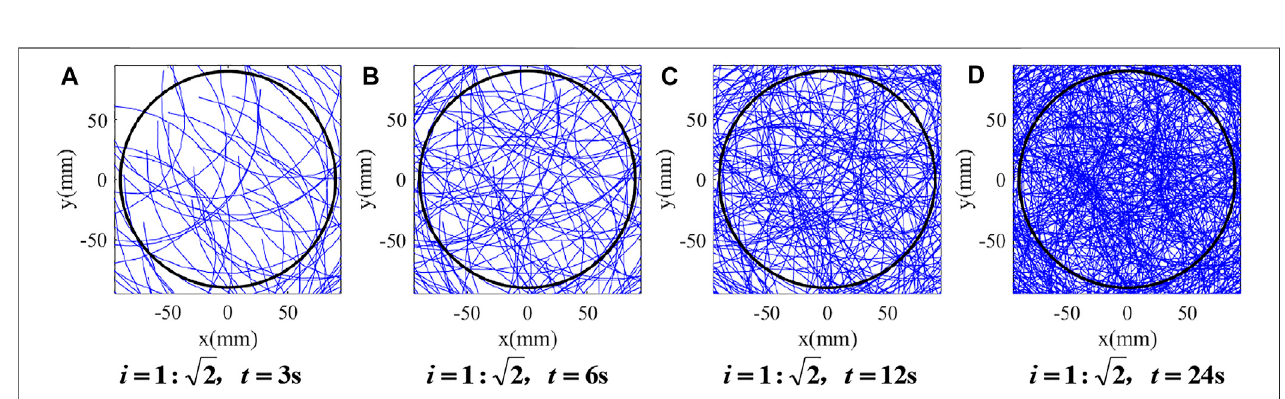
(cid:1)(cid:1) √ , t (cid:1) 3s. (B) i (cid:1) 1 : 2